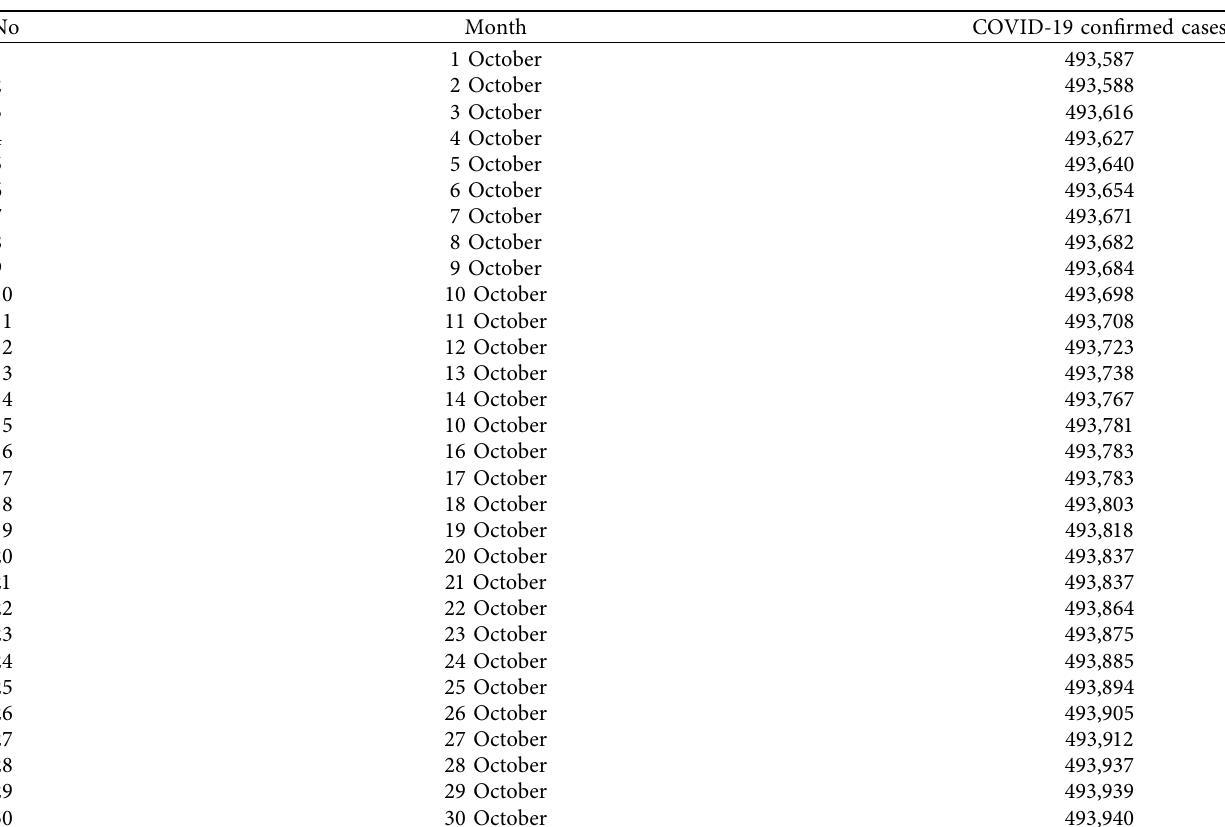
Table 3: Monthly e cases of COVID-19 in Ethiopia from October 1, 2022 to October 30, 2022.